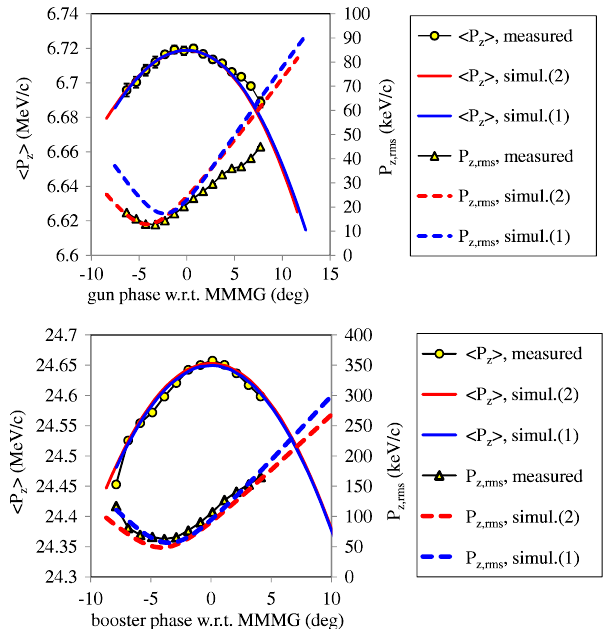
FIG. 17. Measured and simulated 1 nC emittance as a function of the gun phase w.r.t. MMMG phase. The measurements have been performed using an rms laser spot size of 0.3 mm. Parameters corresponding to Table I were applied for the